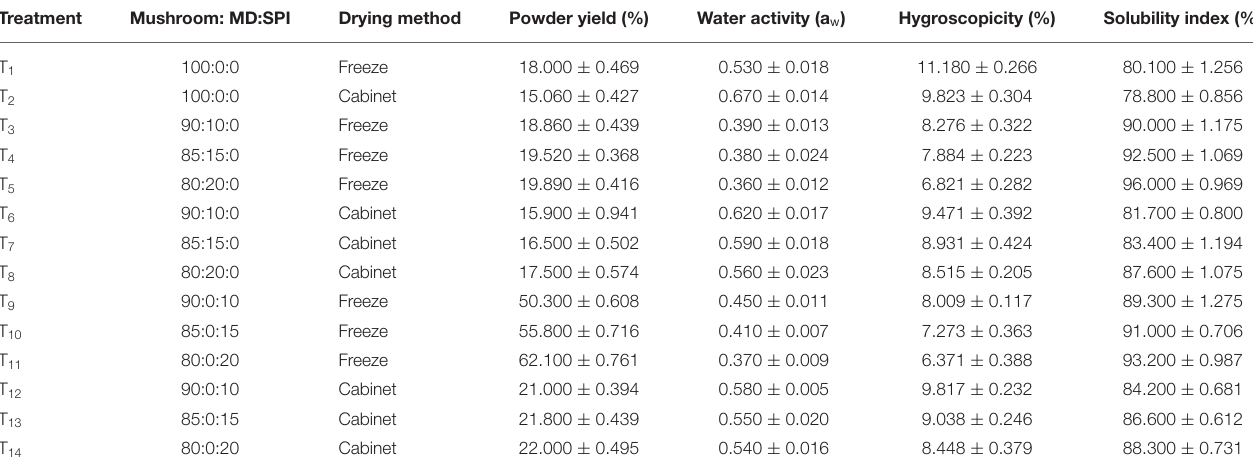
TABLE 2 | Functional properties of BMP.